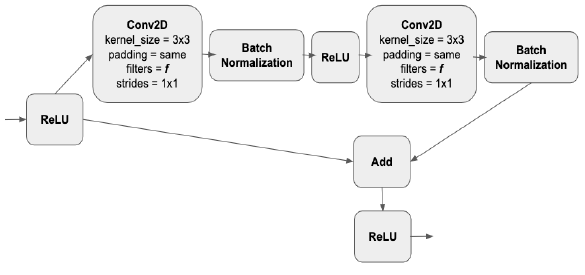
Figure 7. Residual Block for the MM-HR model shown in Figure 4. f depends on the number of input filters to the